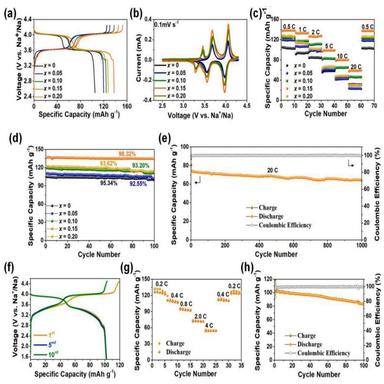
Electrochemical performances of Na3V2-xFex(PO4)2O2F (x = 0, 0.05, 0.1, 0.15, 0.2) electrodes in coin cells versus sodium metal: (a) GCD curve at 1C; (b) CV curve at 0.1 mV s − 1 in the voltage range of 2.5–4.3 V; (c) Rate capability; (d) Cycling performance at 1C; (e) Cycling performance at 20C of NVFPOF and (f) GCD curves; (g) Rate capability; (h) Cycling performance at 0.4C of Sodium-ion full battery.